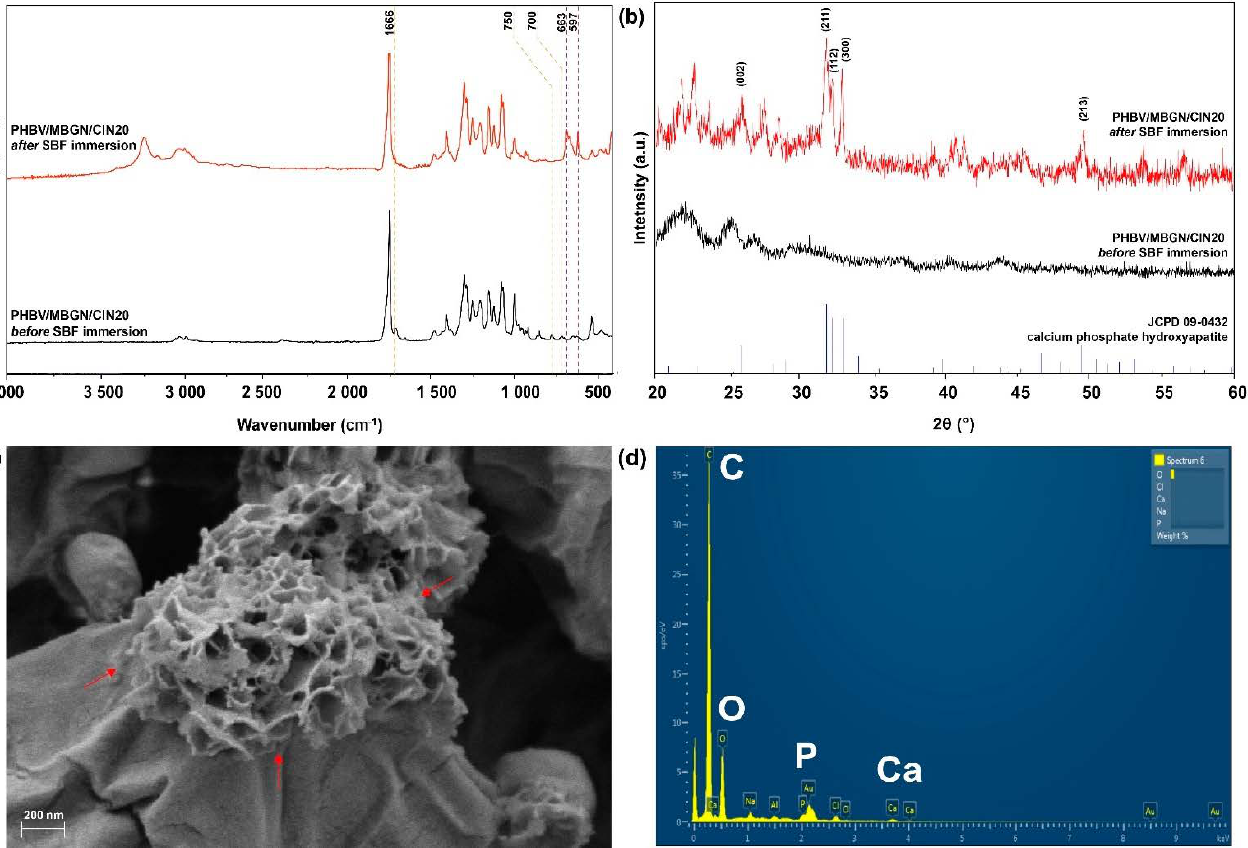
Figure 6. The bioactivity analysis of PHBV/MBGN/CIN20 microspheres by simulated body fluid (SBF) immersion test: ( a ) FTIR spectra; ( b ) XRD patterns; ( c ) Scanning electron micrograph indicating hydroxyapatite formation on the surface of microspheres, as shown by arrows; ( d ) A representative EDS spectrum showing the presence of C, O, P, and Ca. The peak of Au is detected from the substrate as a result of the gold sputtering process.